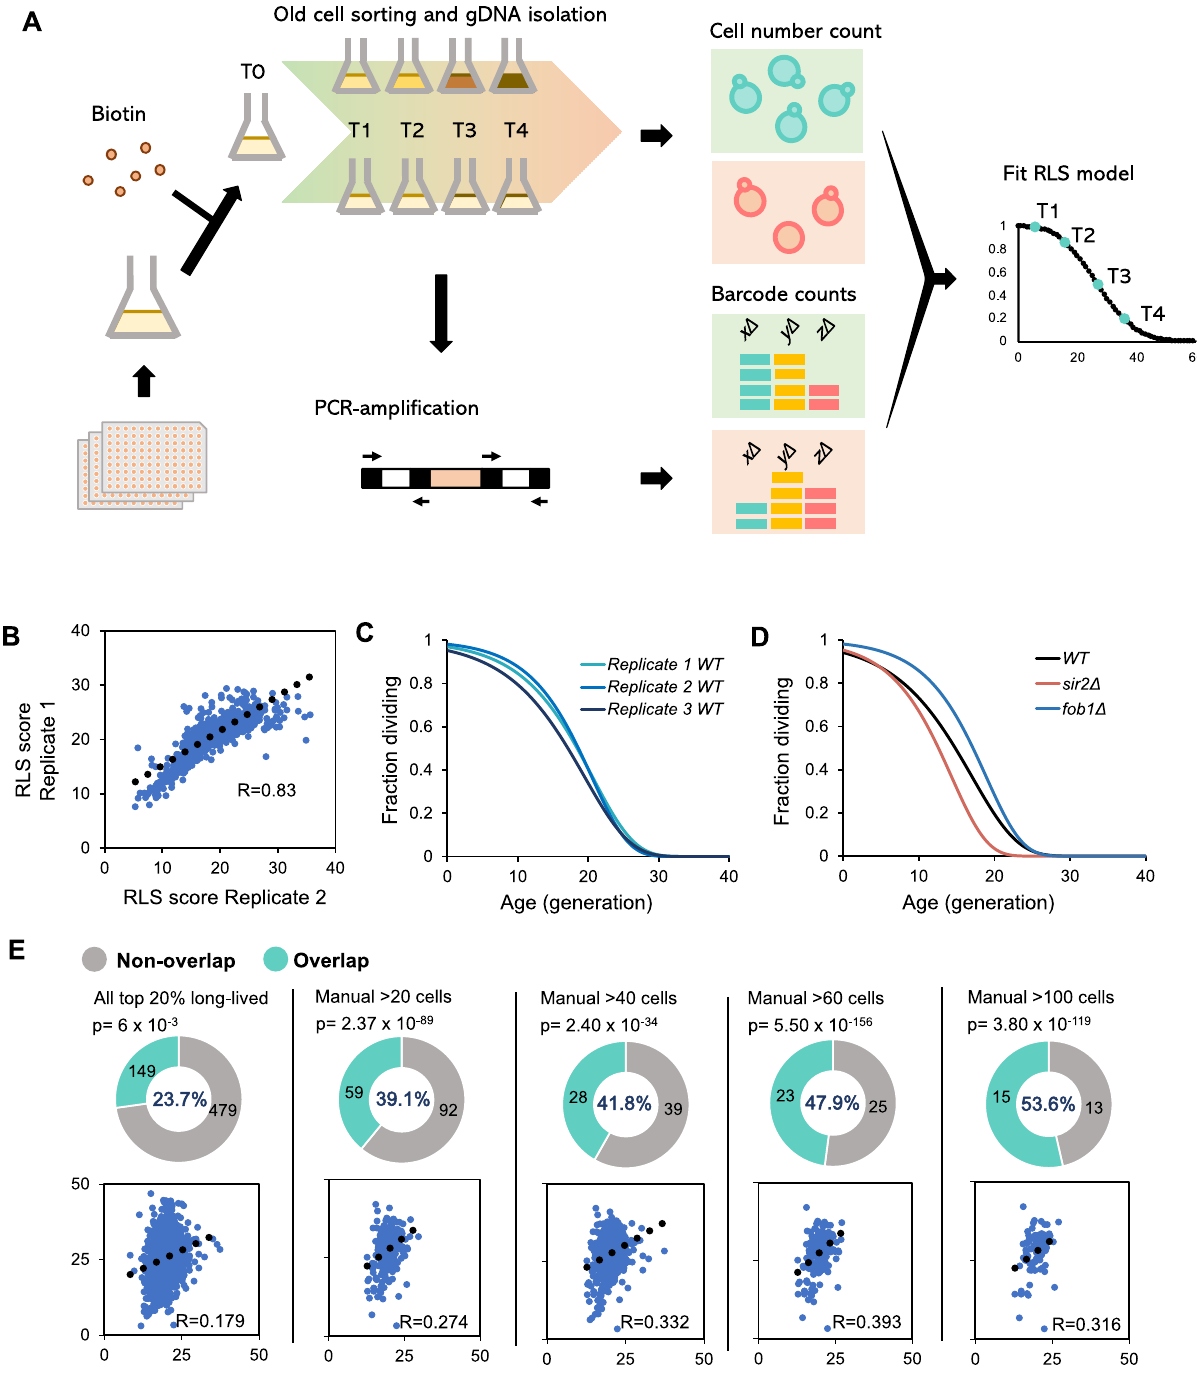
Fig. 1 Pipeline and quality control for SEBYL method. A Pipeline of SEBYL screening method. B Correlation analysis of fi nal RLS score from screening replicate 1 and replicate 2. C Survival curves of wild-type BY4742 strains from three replicates. D Survival curves of wild-type, sir2 Δ and fob1 Δ strains. E Overlap between long-lived yeast deletion strains identi fi ed from SEBYL and manual microdissection screening. Manual results were grouped by number of cells included in experiments. Bottom fi gures indicate correlations between manual and SEBYL results. X -axis indicates SEBYL RLS score, Y -axis indicates RLS measured by manual screen. p -value calculated by χ 2 test. See also Fig.